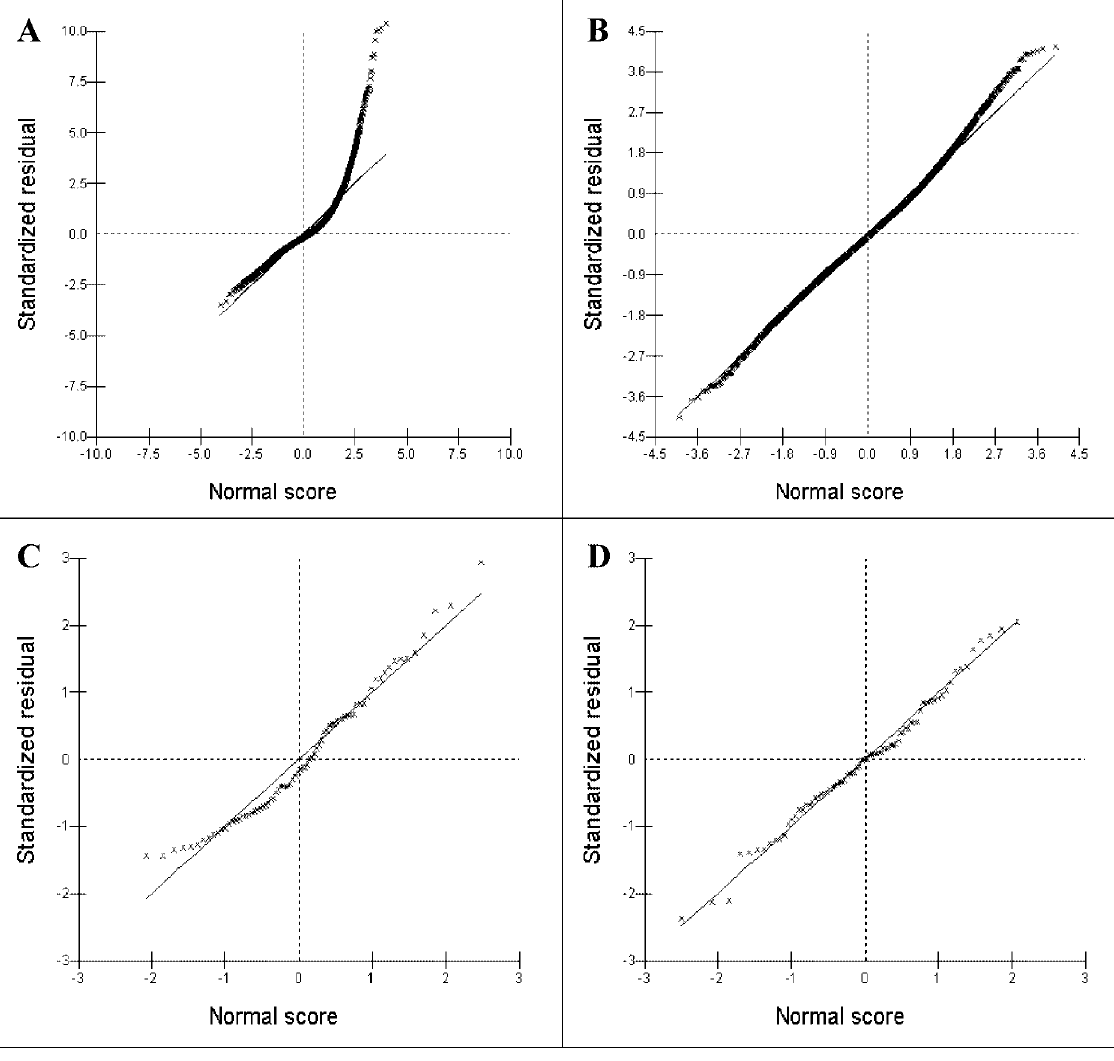
Fig. 1. Plots of residuals for the “empty” model of NA. A, B – level-1 residuals, before and after log transform, respectively. C, D – level-2 residuals, before and after log transform, respectively. Straight lines represent ideally normal